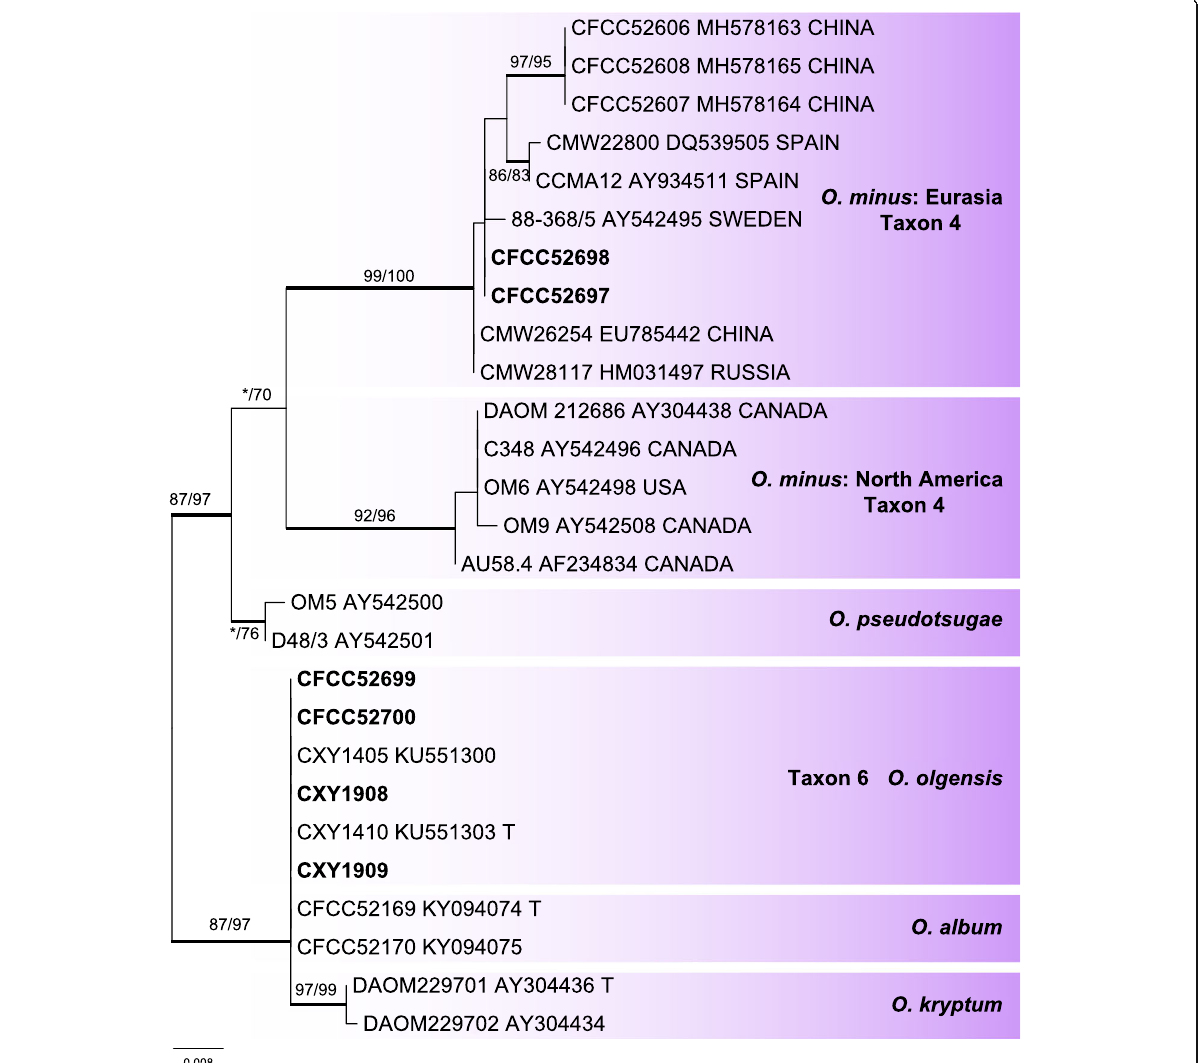
Fig. 4 ML tree of O. minus complex generated from the ITS sequence data. Sequences generated from this study are printed in bold. Bold branches indicate posterior probability values ≥ 0.9. Bootstrap values of ML/MP ≥ 70% are recorded at the nodes. T = ex-type